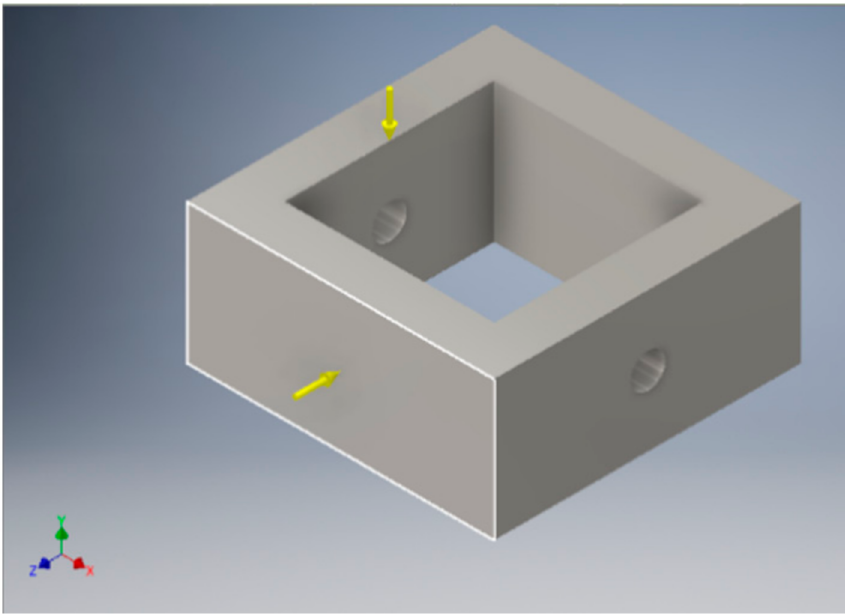
Figure 5. Overview of the force applied on the slider.